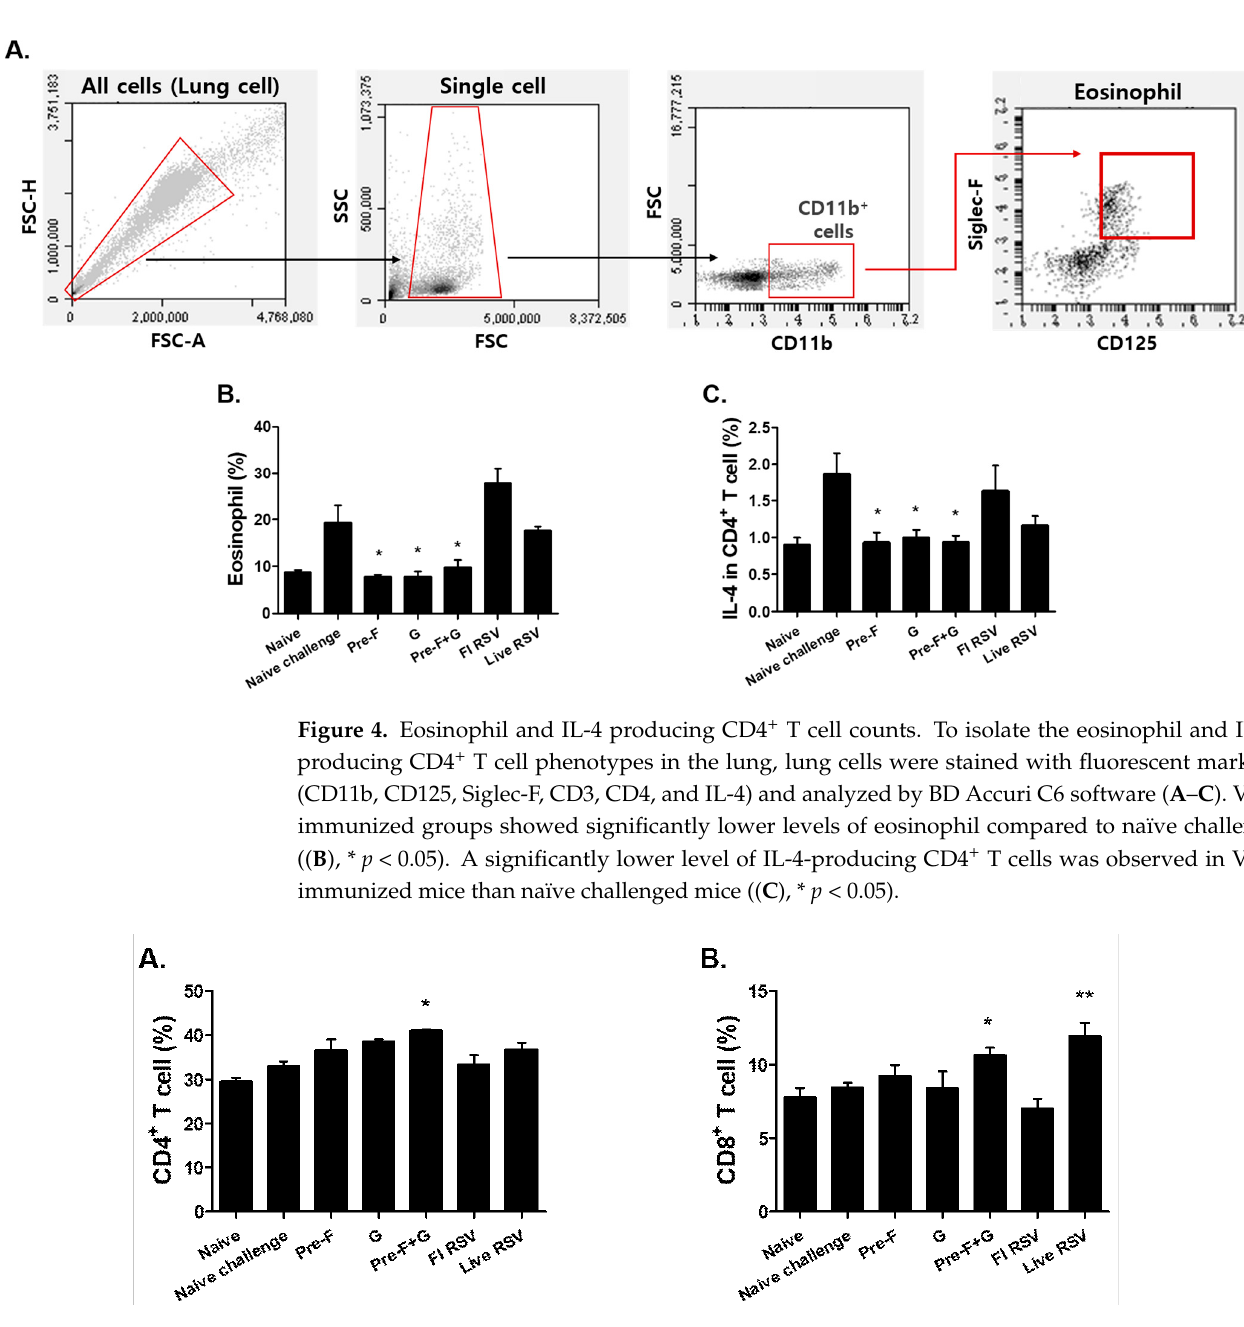
Figure 5. CD4 + and CD8 + T cell counts in lung. To isolate the CD4 + and CD8 + T cells in the lung, lung cells were stained with surface markers (CD3, CD4, and CD8) and analyzed with BD Accuri soft- ware ( A , B ). Data were acquired on an individual basis from each group (n = 6) and presented as